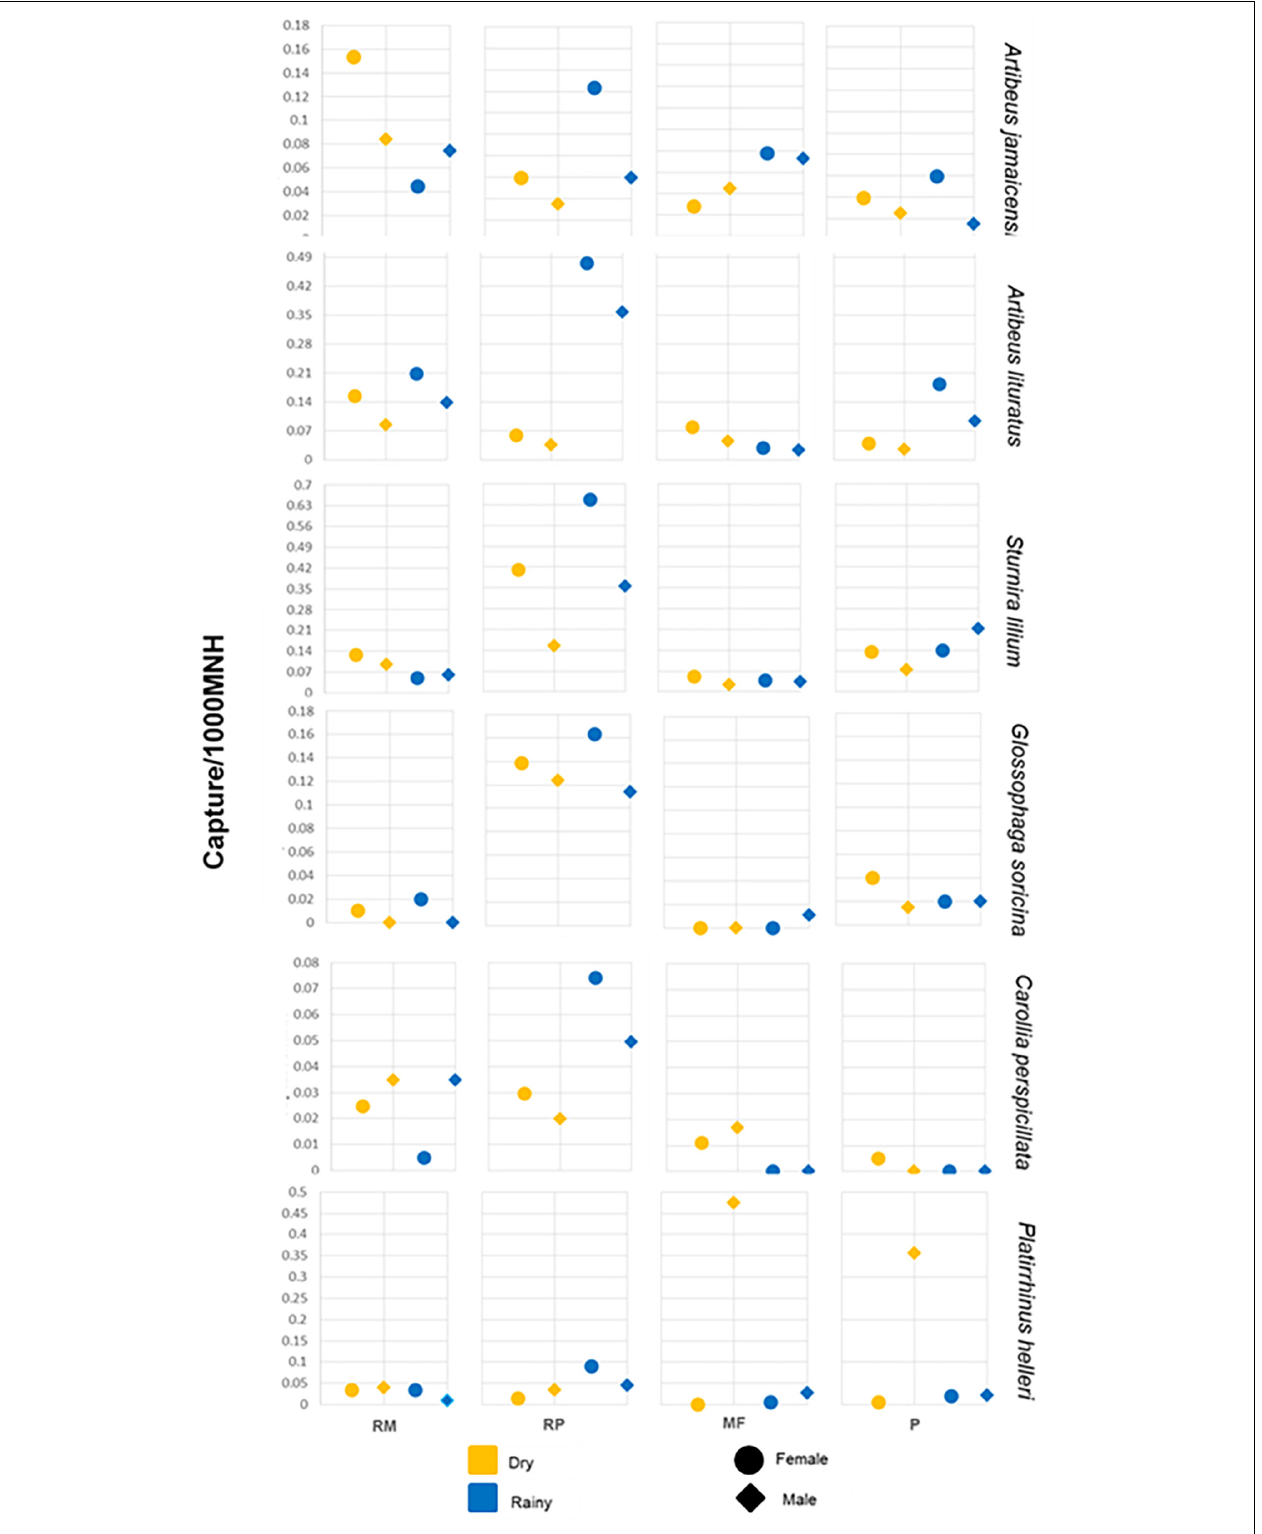
FIGURE 2 | Capture rate (bats/mist net hour) of males and females of six bat species across different habitat types at the Lacandona rain forest during the dry and rainy seasons.